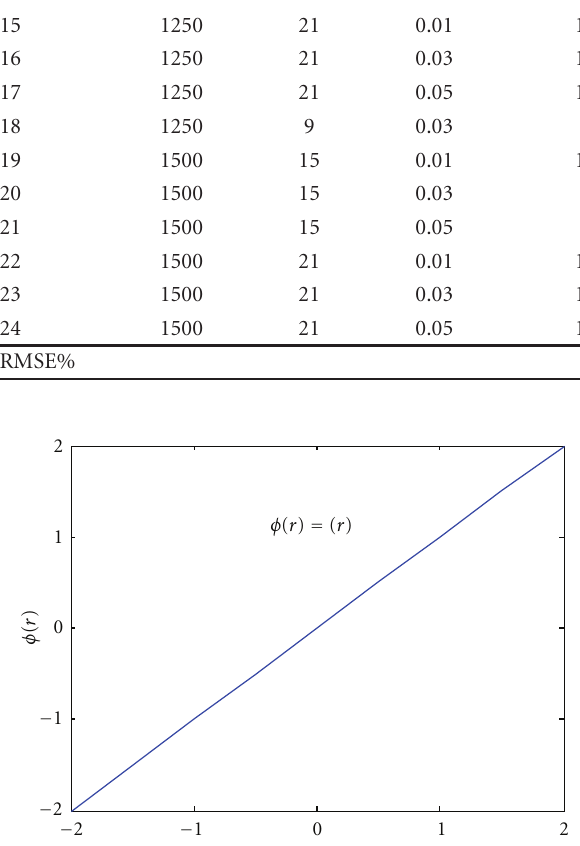
are obtained and probably better results may be